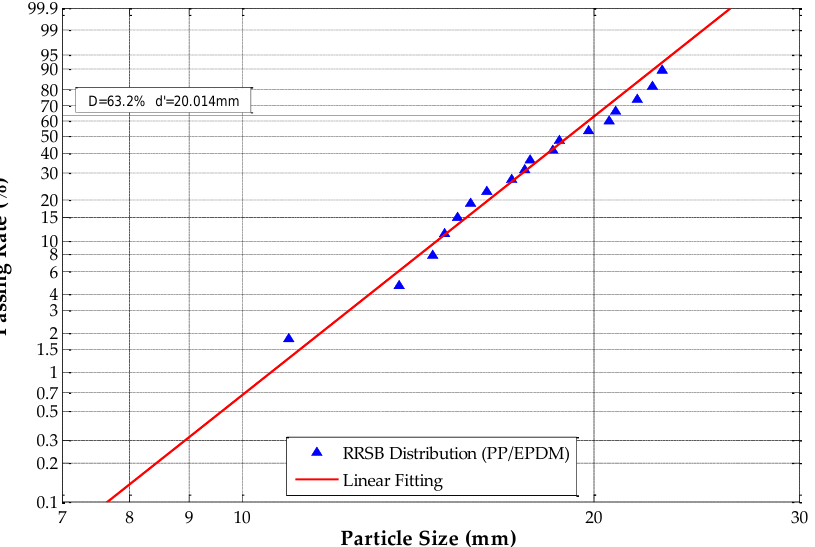
Figure 11. RRSB distribution of polypropylene/ethylene-propylene-diene-monomer (PP/EPDM)